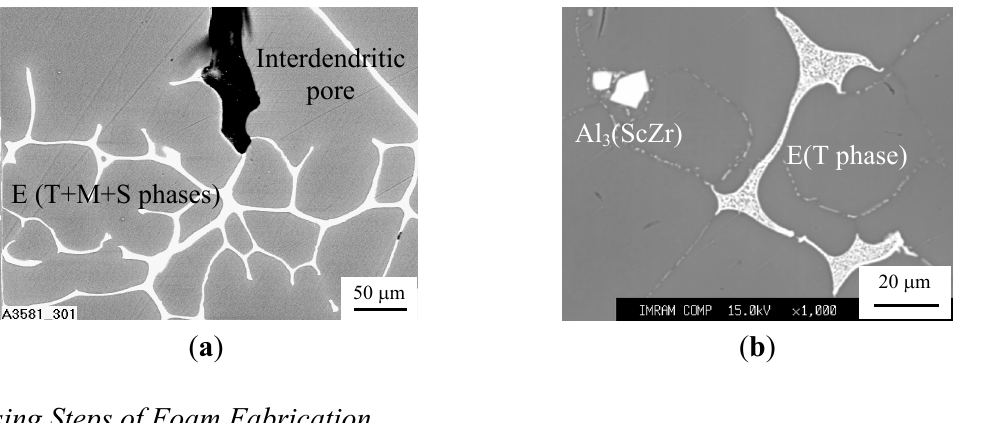
Figure 6. SEM micrographs of different matrix AlZnMg-alloys: ( a ) ZAM 1 and ( b ) ZAM 2.